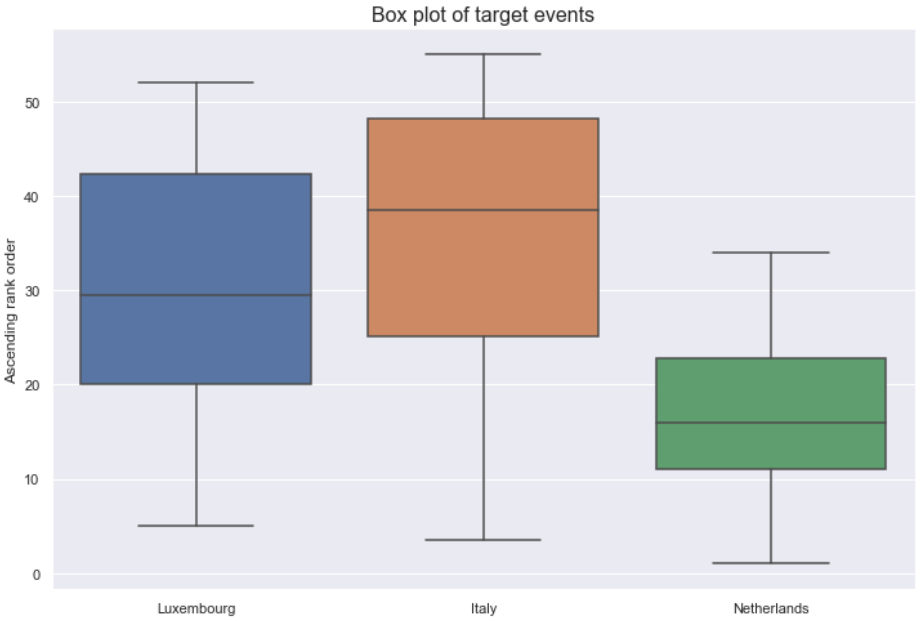
Figure 2. Box plot of target events for each country.